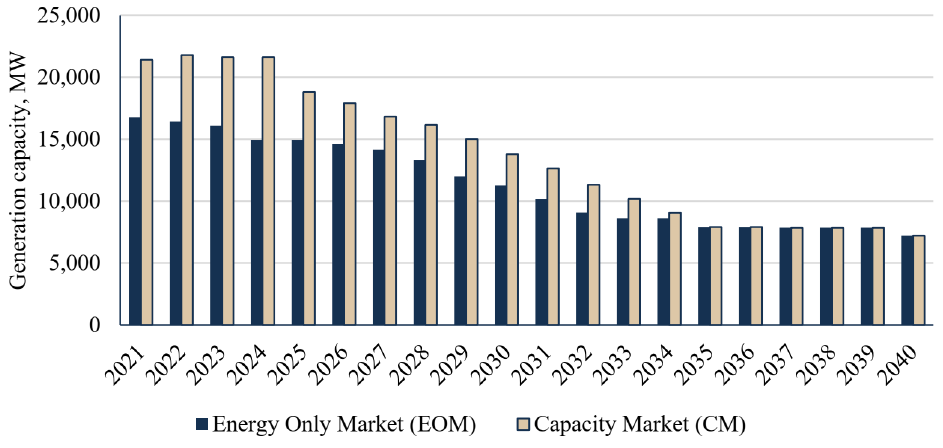
Figure 11. Hard coal-fired generation capacity under the EOM and CM scenarios in 2021–2040.